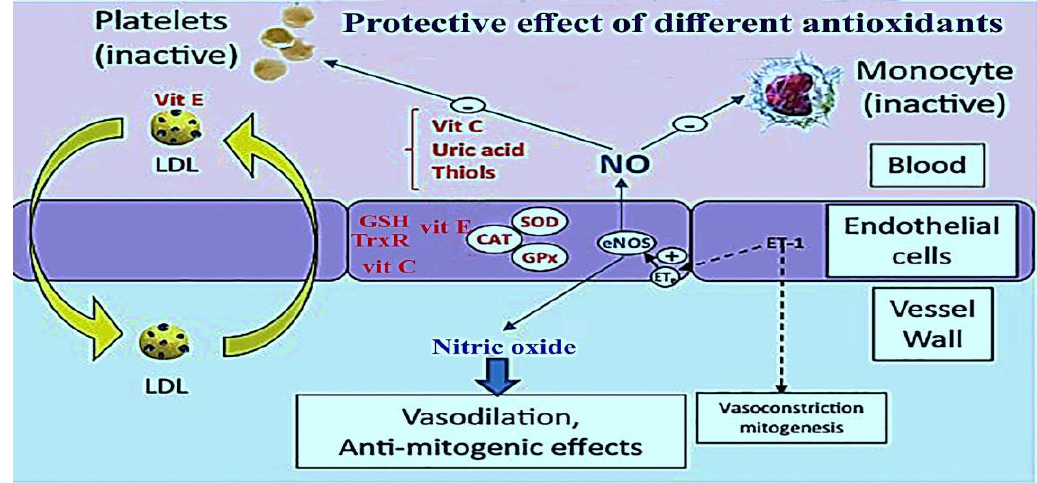
Figure 2. The protective effects of antioxidants on the stages of atherosclerosis [9].